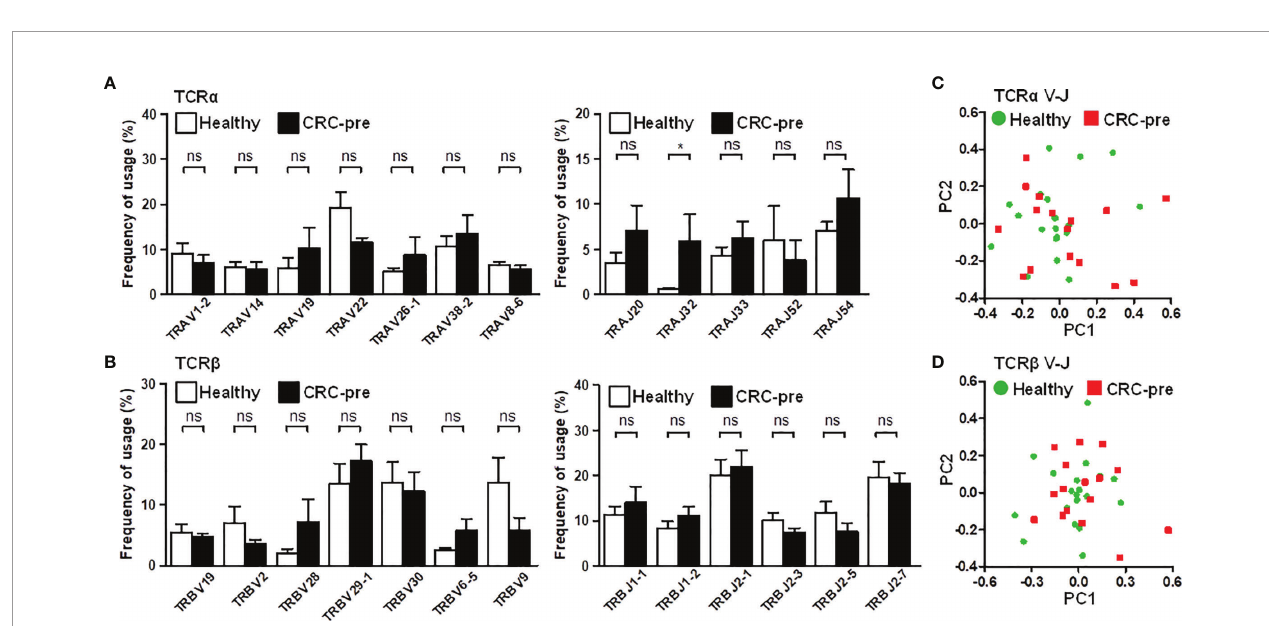
FIGURE 3 | TCR a and TCR b V and J gene usage in CRC patients and healthy controls. (A) Prevalent TCR a variable genes (TRAV; left panel) and joining genes (TRAJ, right panel) in healthy controls (white columns) and CRC-pre samples (black columns) are illustrated in bar graphs. (B) Highly expressed TCR b variable (TRBV; left panel) and joining genes (TRBJ, right panel) in healthy controls (white columns) and CRC-pre samples (black columns) are shown as bar graphs. Statistical signi fi cance was determined using unpaired Student ’ s t-test method. Principal component analysis (PCA) of TCR a (C) and TCR b (D) V-J gene recombination across healthy controls (n = 20; green circles) and CRC-pre samples (n = 16; red squares). ns p > 0.05, *p <